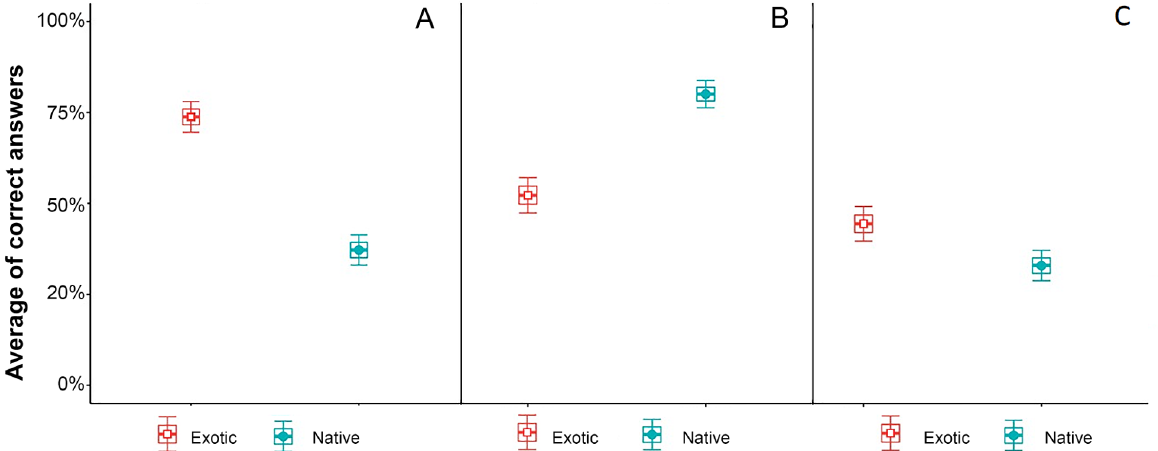
Figure 2. Percentual average of recognition level of a) species’ name identification, b) species’ origin identification, c) recognition rate. The central point corresponds to the means, the boxes correspond to the standard error and the bars correspond to the confidence intervals at 95%.